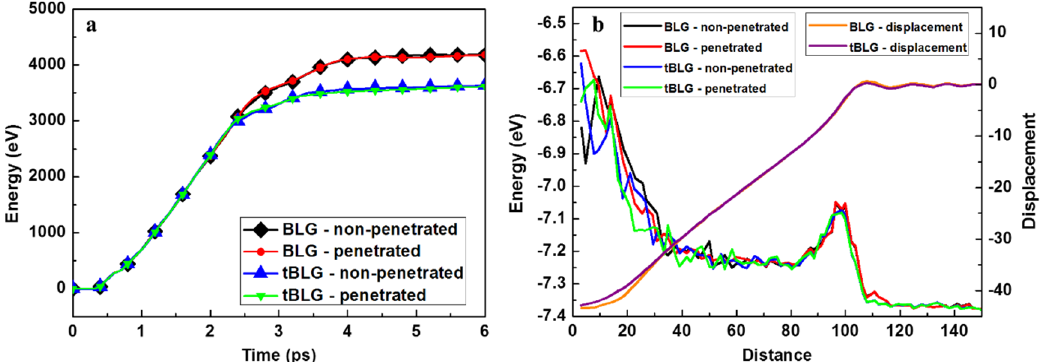
Figure 2. Energy propagation in different samples. ( a ) Energy is absorbed by the first graphene layer of BLG and tBLG samples during the impact process. ( b ) The profile of energy and out-of-plane displacement along the armchair direction of the second graphene layer for BLG and tBLG samples at t = 3.0 ps.